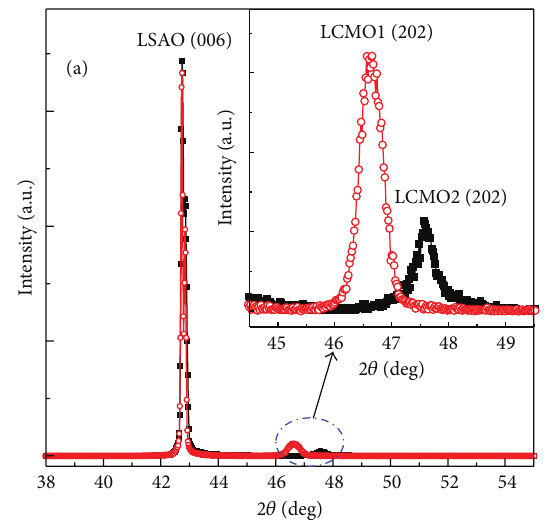
Figure 1: XRD patterns of LCMO films on miscut LSAO substrates. The inset shows the details of the LCMO peaks. Except for the (00 l ) LSAO substrate and the ( h 0 h ) LCMO film reflections, there was no diffraction